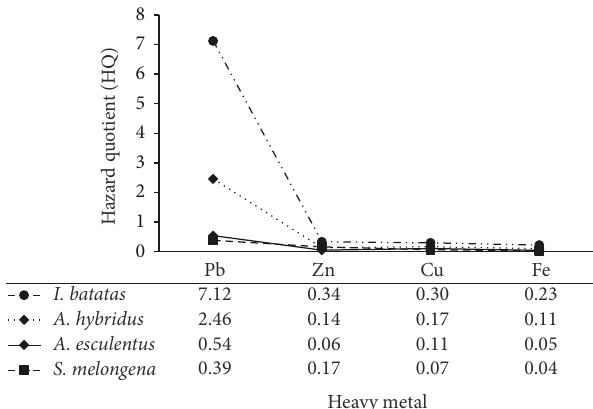
Figure 2: Hazard quotient (HQ) of individual metal for the studied